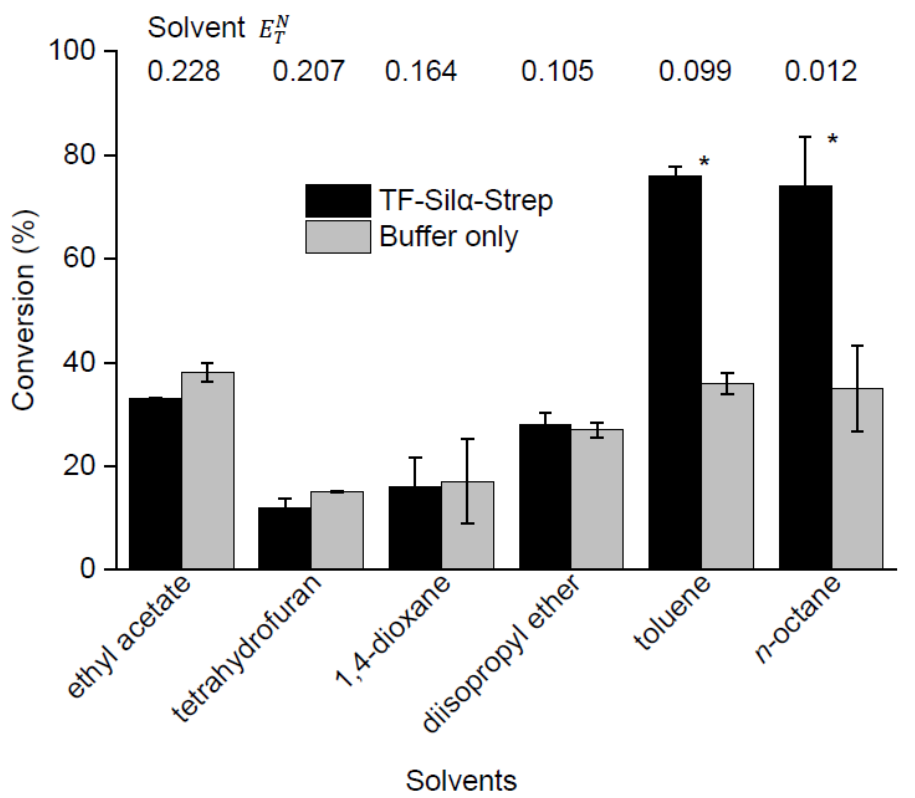
Figure 3. Graph showing percentage conversions of m -methoxyphenol and triethylsilanol condensations in a range of solvents after 72 h. A one-tailed Student’s t -test assuming unequal variance was performed, comparing each enzyme to its control. Comparisons resulting in a p < 0.05 were deemed to be significant and are marked with *. The normalised electronic transition energies for the corresponding solvents are shown inset.